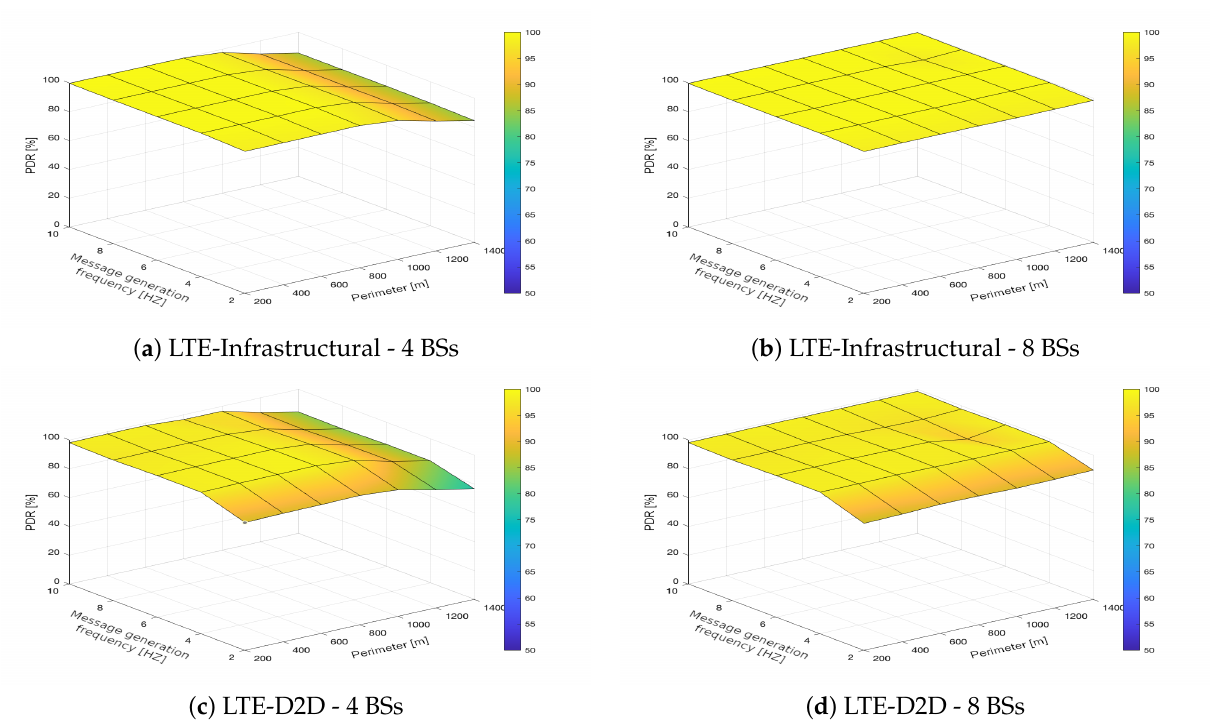
Figure 15. PDR simulated for the both modes of the 4G-based C-V2X technology, both infrastructure density deployments and traffic intensity of 1500 vehicles per hour.